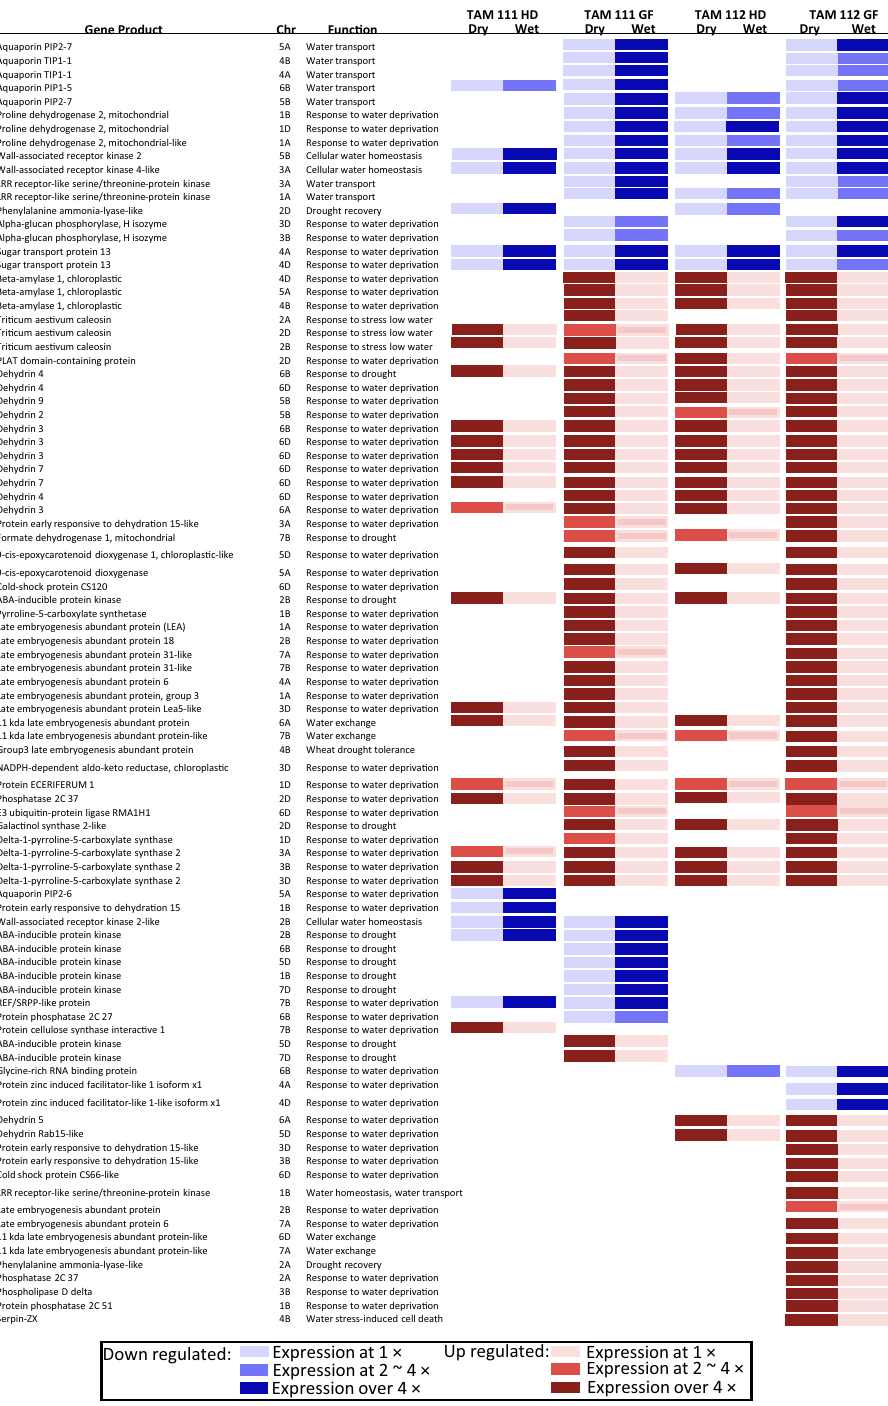
Figure 5. Expression heat map of differentially expressed genes (DEGs) response to water deprivation stress in TAM 111 and TAM 112 under dry and wet conditions at heading and grain filling stages. Chr = Chromosome, HD = heading stage, and GF = grain filling